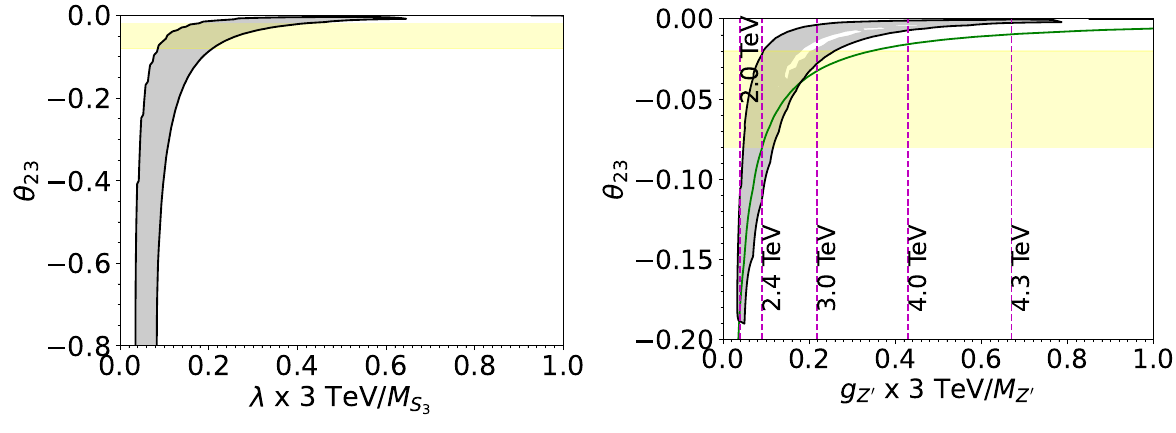
Figure 6 . Two parameter fit to the S 3 leptoquark model (left panel) and the B 3 − L 2 Z 0 model (right panel). Shaded regions are those preferred by the global fit at the 95 % confidence level (CL). The yellow region displays the domain | θ 23 | ∈ {| V cb | / 2 , 2 | V cb |} to guide the eye. The region below the green curve in the right-hand plot is incompatible with the ∆ M s measurement considered on its own at the 95 % CL. There is no such domain in the leptoquark case, explaining the lack of a green curve in the left-hand panel. Our datasets are identical (save for BR ( B s → µ + µ − ) as detailed in section 4.1 and R ) to those defined by smelli2.3.2 and we refer the curious reader to its K ( ∗ )